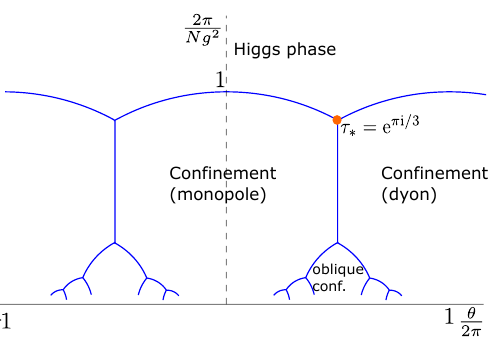
Figure 1. Conjectured phase diagram of the Cardy-Rabinovici model. The electric particle condenses in the weak coupling region (Higgs phase), and the magnetic particle condenses in the strong coupling region (confinement phase). Because of the Witten e ff ect, the dyon tends to condense by increasing θ . Taken from